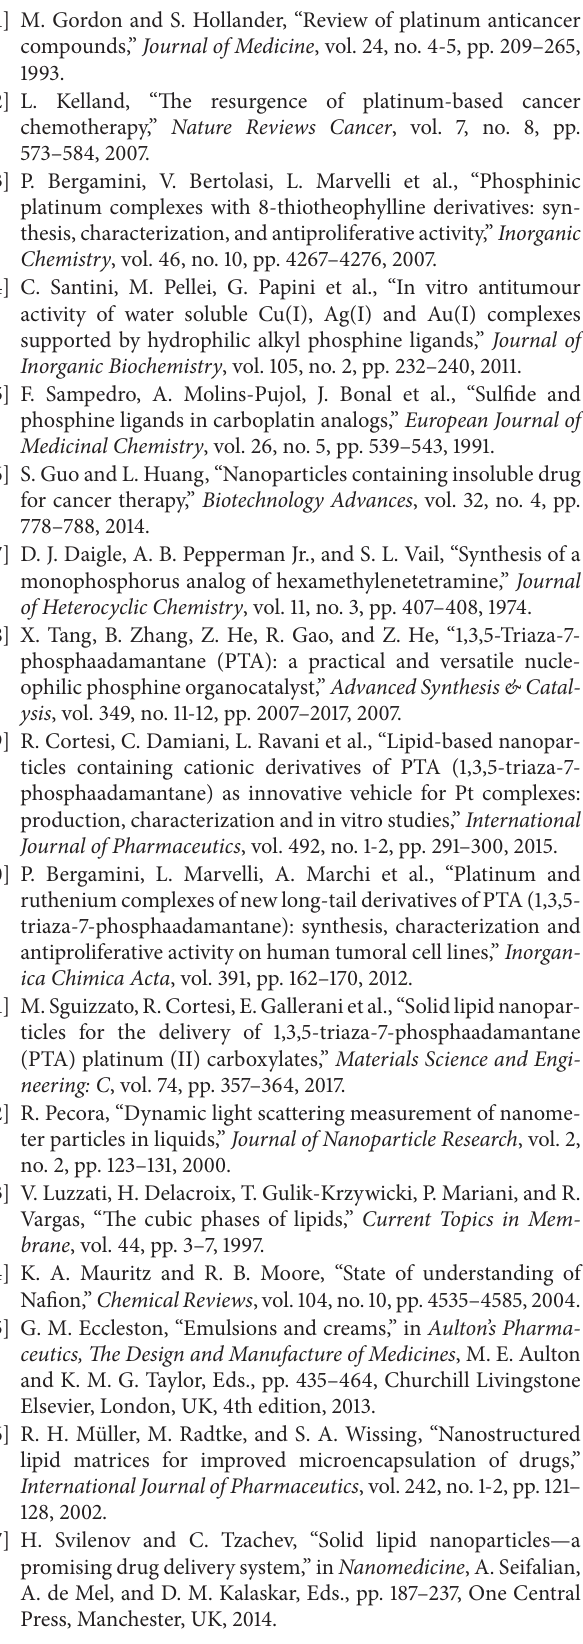
Table 3: 𝑍 -average diameter and polydispersity of NAF-supported cis -[Pt(PTAH + ) 2 Cl 2